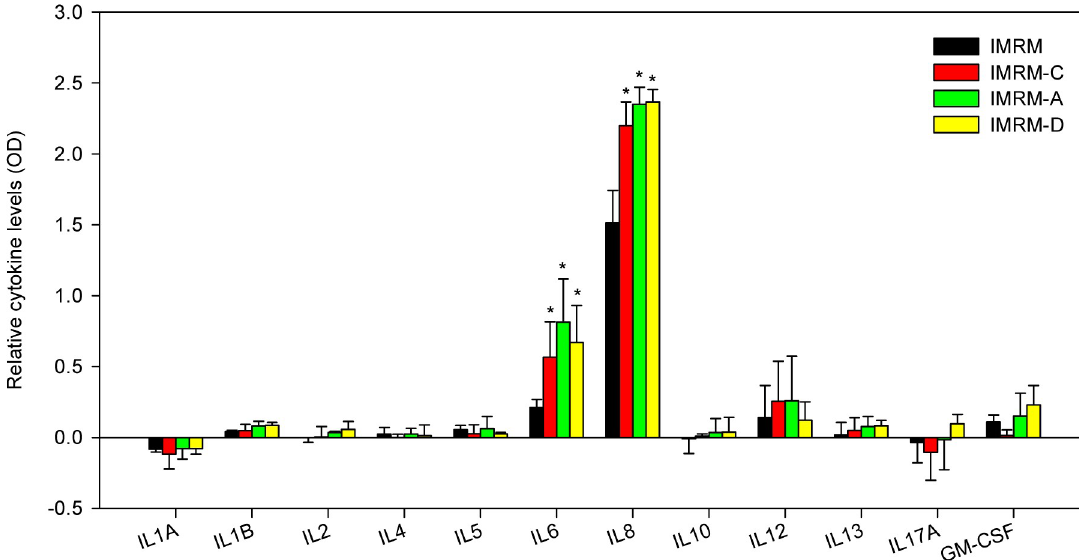
Fig 4. Asbestos-exposed IMR-90 cells show increased cytokine secretion. Cytokines in the supernatants of IMR-90 cells exposed or unexposed to asbestos for 24 h were measured using ELISA. The results are expressed as mean ± SD after subtracting negative value from each value. � P < 0.05, vs. IMRM group, n =